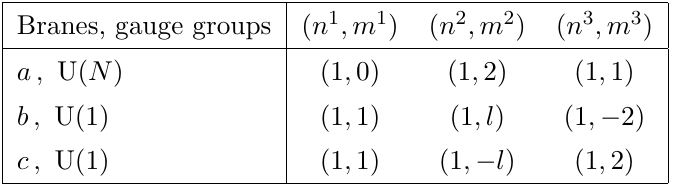
Table 1 . Intersecting D-brane model. Wrapping numbers of a stack of N branes, a , and two single branes, b and c